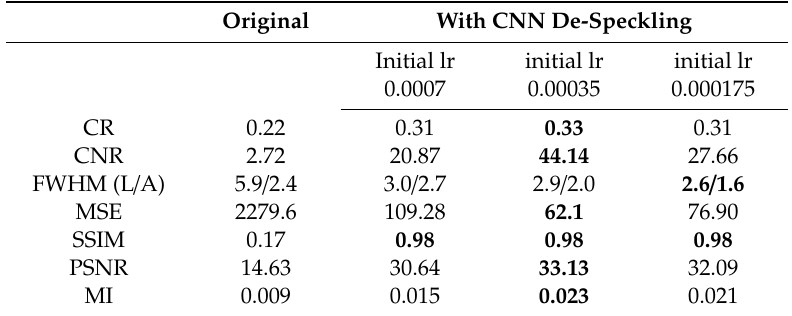
Figure 8. Reconstructed echogenicity maps of the mixed loss model with di ff erent initial learning rate. Table 6. Quantitative analysis of di ff erent initial learning